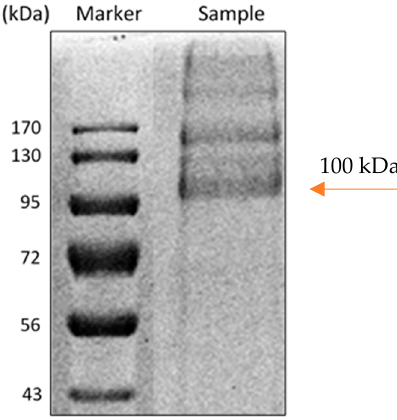
Figure 3. SDS-PAGE image of carbamoylase: The lane Marker is molecular weight standards, the lane Sample is purified carbamoylase. Arrow indicates the 100 kDa molecular weight of the enzyme.